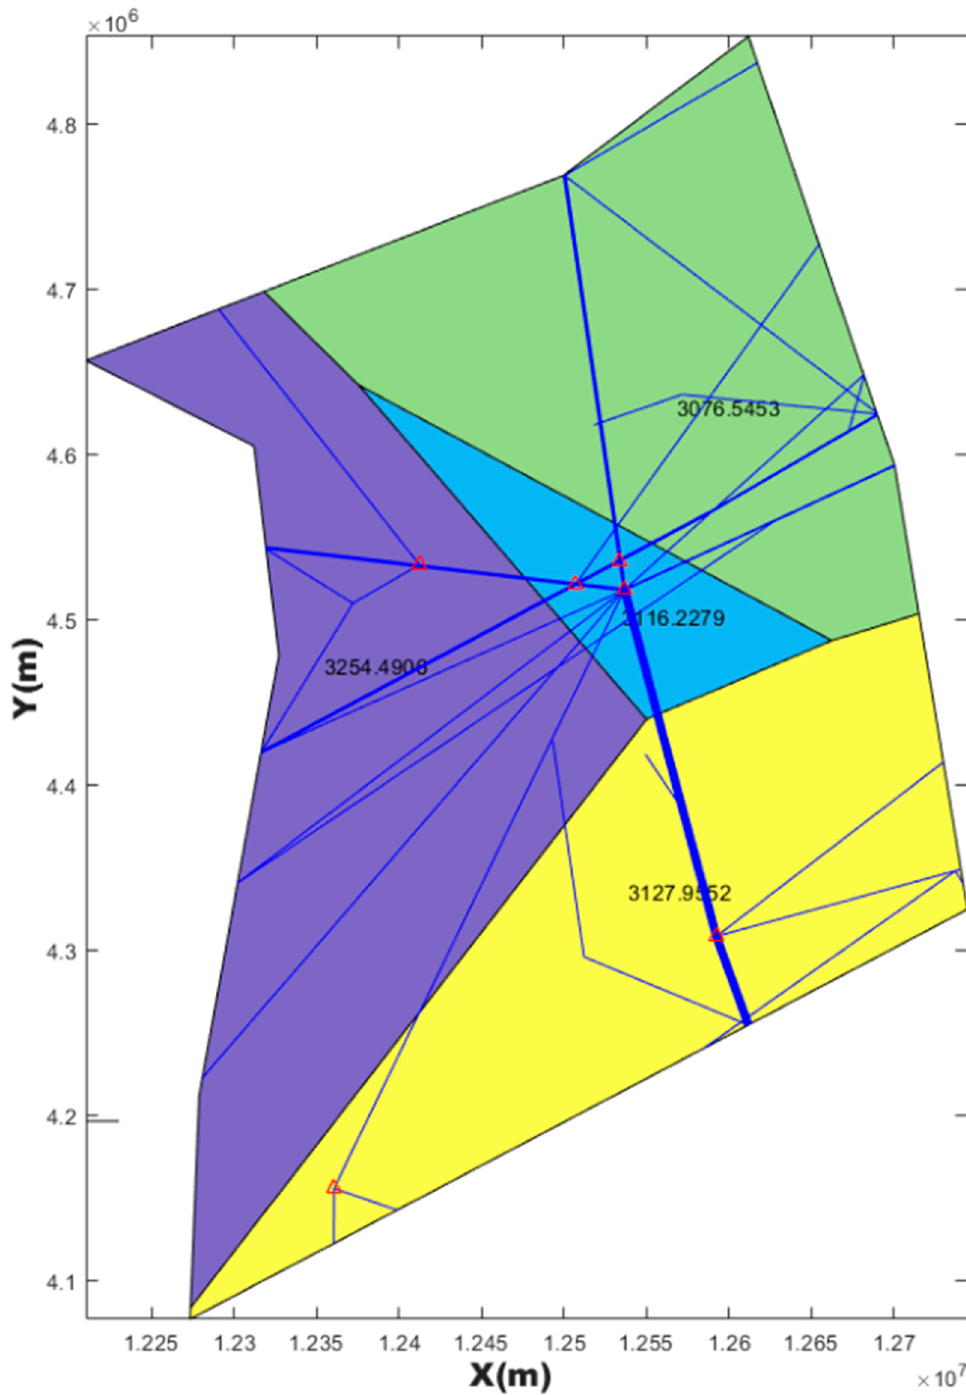
Figure 19. Post-processing results of Figure 15 with MC-CLFV.